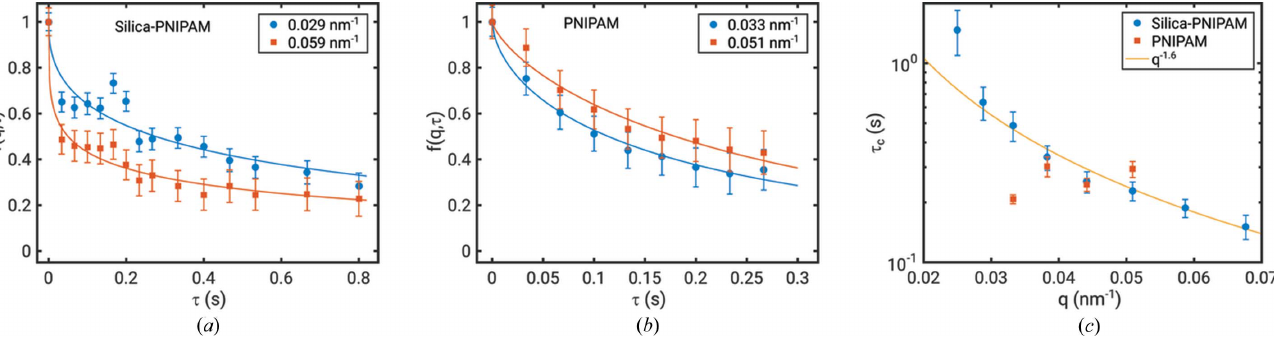
Figure 4 Dynamics results. ( a ) and ( b ): intermediate scattering functions for both samples at two q values. The solid lines are fits of equation (3). ( c ) Relaxation time (cid:2) as function of q . The solid line shows a fit of (cid:2) c